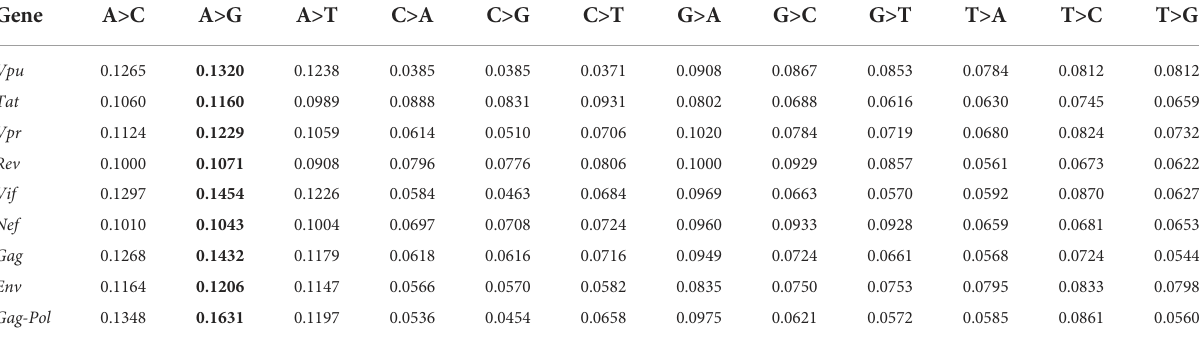
TABLE 1A The ratios of 12 unique mutations per gene.